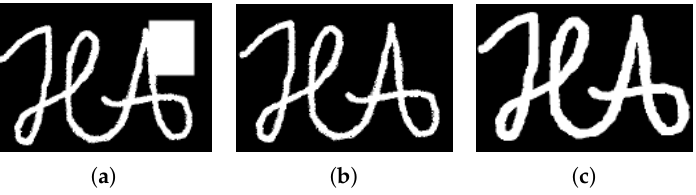
Figure 1. Two images and a reference image with the same Hamming distances but different topology; ( a ) compared image 1; ( b ) reference image; ( c ) compared image